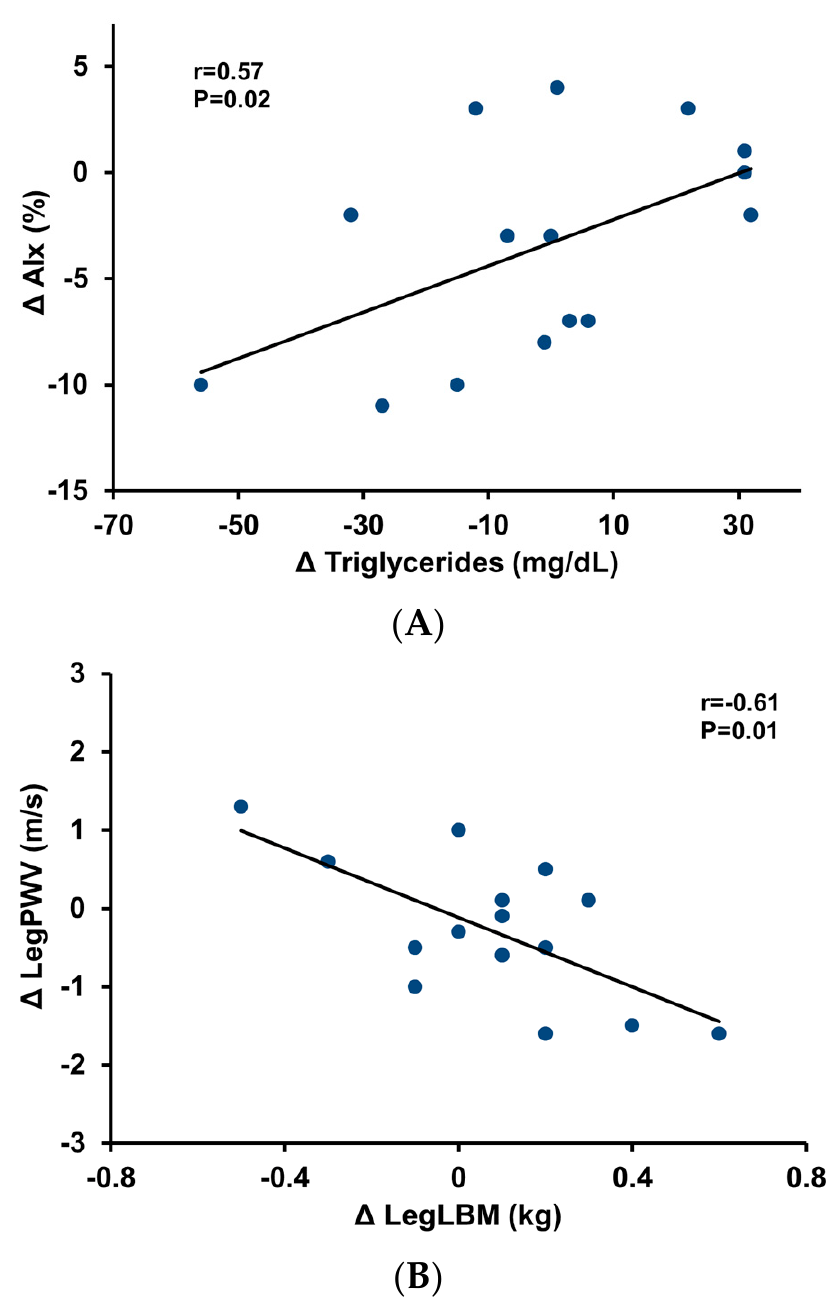
Figure 2. Relationship between the change in triglycerides and the change in augmentation index in response to resistance training (panel ( A )). Relationship between the change in leg lean body mass and the change in leg pulse wave velocity in response to resistance training (panel ( B )). AIx, augmentation index; PWV, pulse wave velocity; LBM, lean body mass.